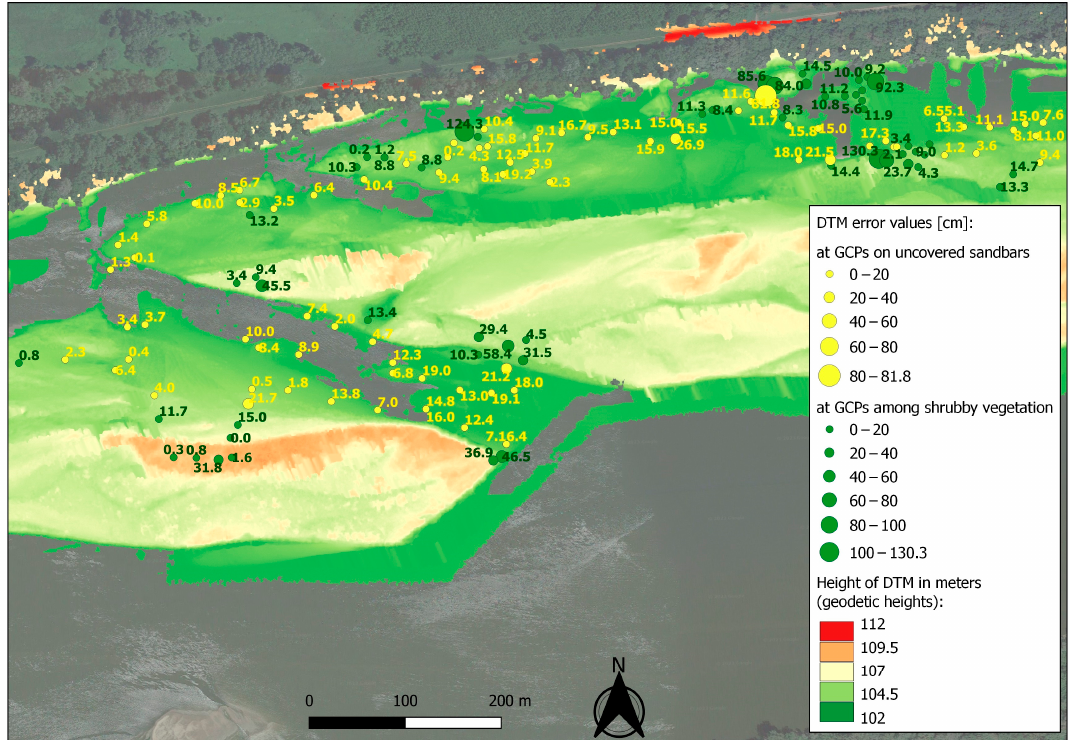
Figure 12. DTM visualization of the Northern Island (central-western section) with height error values at the GCP locations. Digital elevation model based on laser scanning from UAV (ULS). GCPs shown correspond to two vegetation and geomorphological classes: (1) shrub vegetation on the riverine islands and transforming higher level of sandbars, (2) uncovered sandy deposits on sandbars. Background orthophotomap: Google Satellite (with partial transparency).